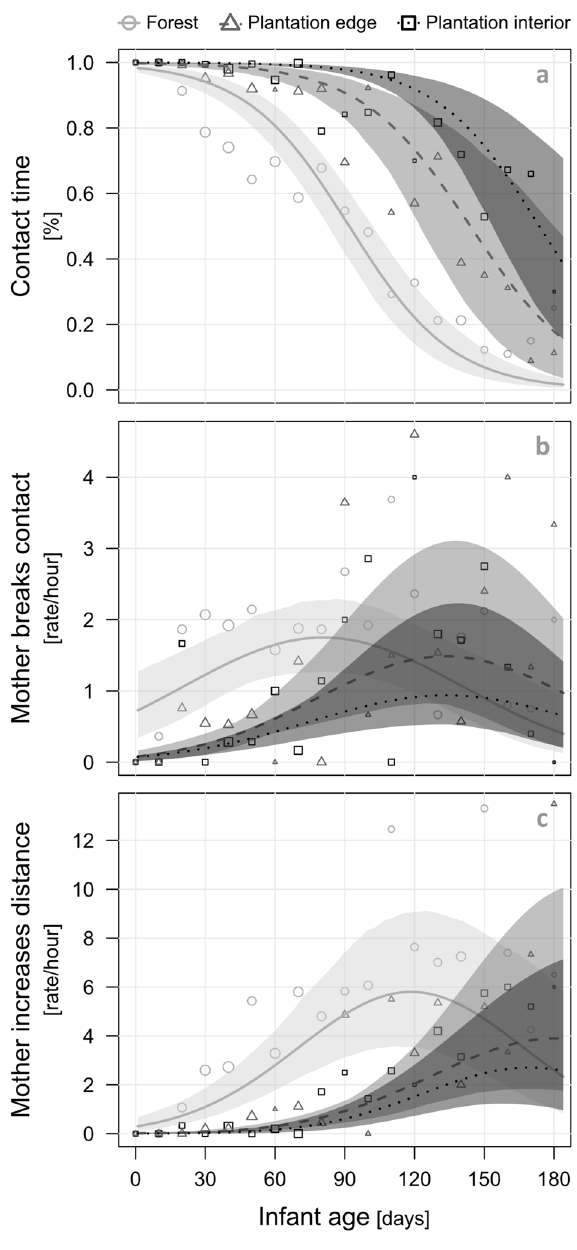
Figure 6. Effect of oil palm plantations on the mother–infant relationship in Macaca nemestrina . Shown are the contact time between macaque mothers and their dependent offspring ( a ) and maternal facilitation of infant independence, measured as rates of breaking contact ( b ) and increasing distance ( c ), as a function of infant age, separately for forest, plantation edge and plantation interior. The lines show the fitted models and the shaded areas their 95% confidence intervals, conditional on continuous control predictors being on their average, and based on infant sex, parity and time of the day manually dummy coded and then centred. For visual clarity, infant age was binned into 10-day sections. The area of the points corresponds to the respective sample sizes (Total N = 491 focal observations of 11 mother–infant